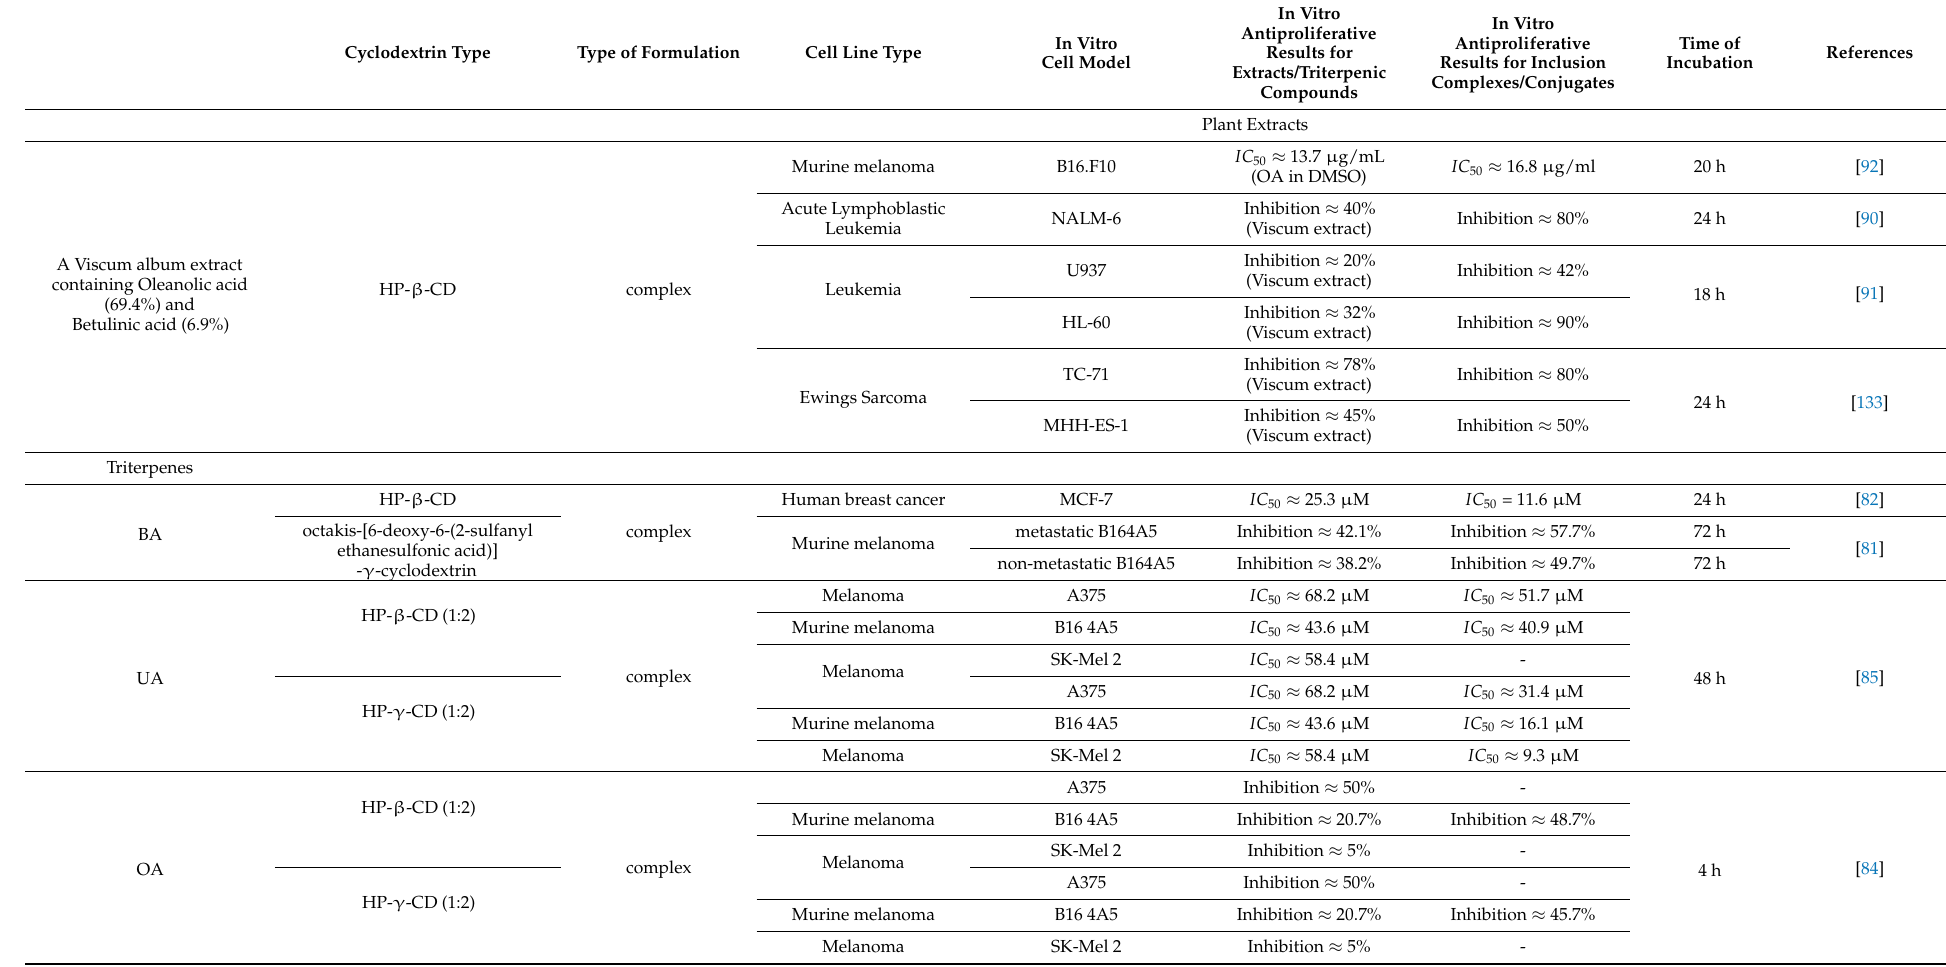
Table 6. In vitro activity of triterpene:cyclodextrin inclusion complexes against cancer cell